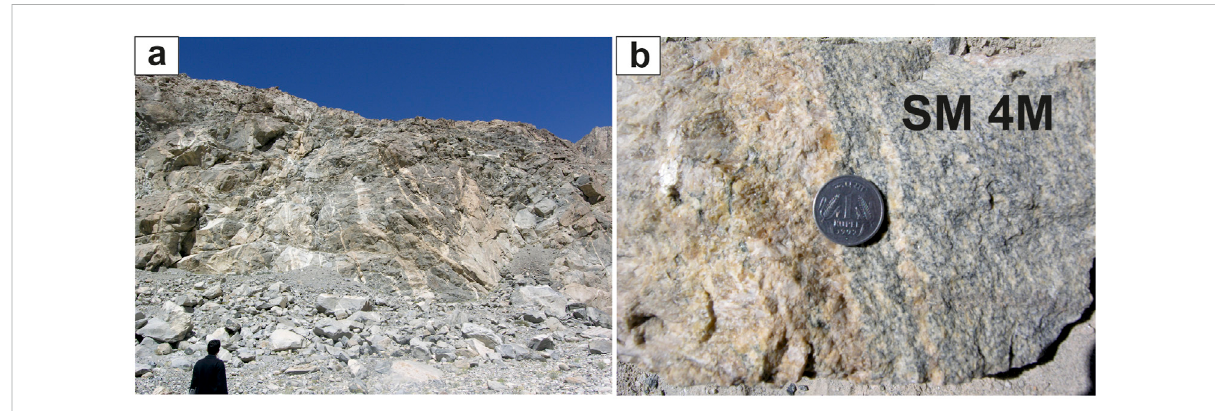
FIGURE 2 (A) High-grade metamorphic rocks and zone of partial melting observed to the north of the Shyok-Muglib strand of the KF known as SMC. (B) Collected sample of tonalite gneiss SM 4 M from the SMC zone of